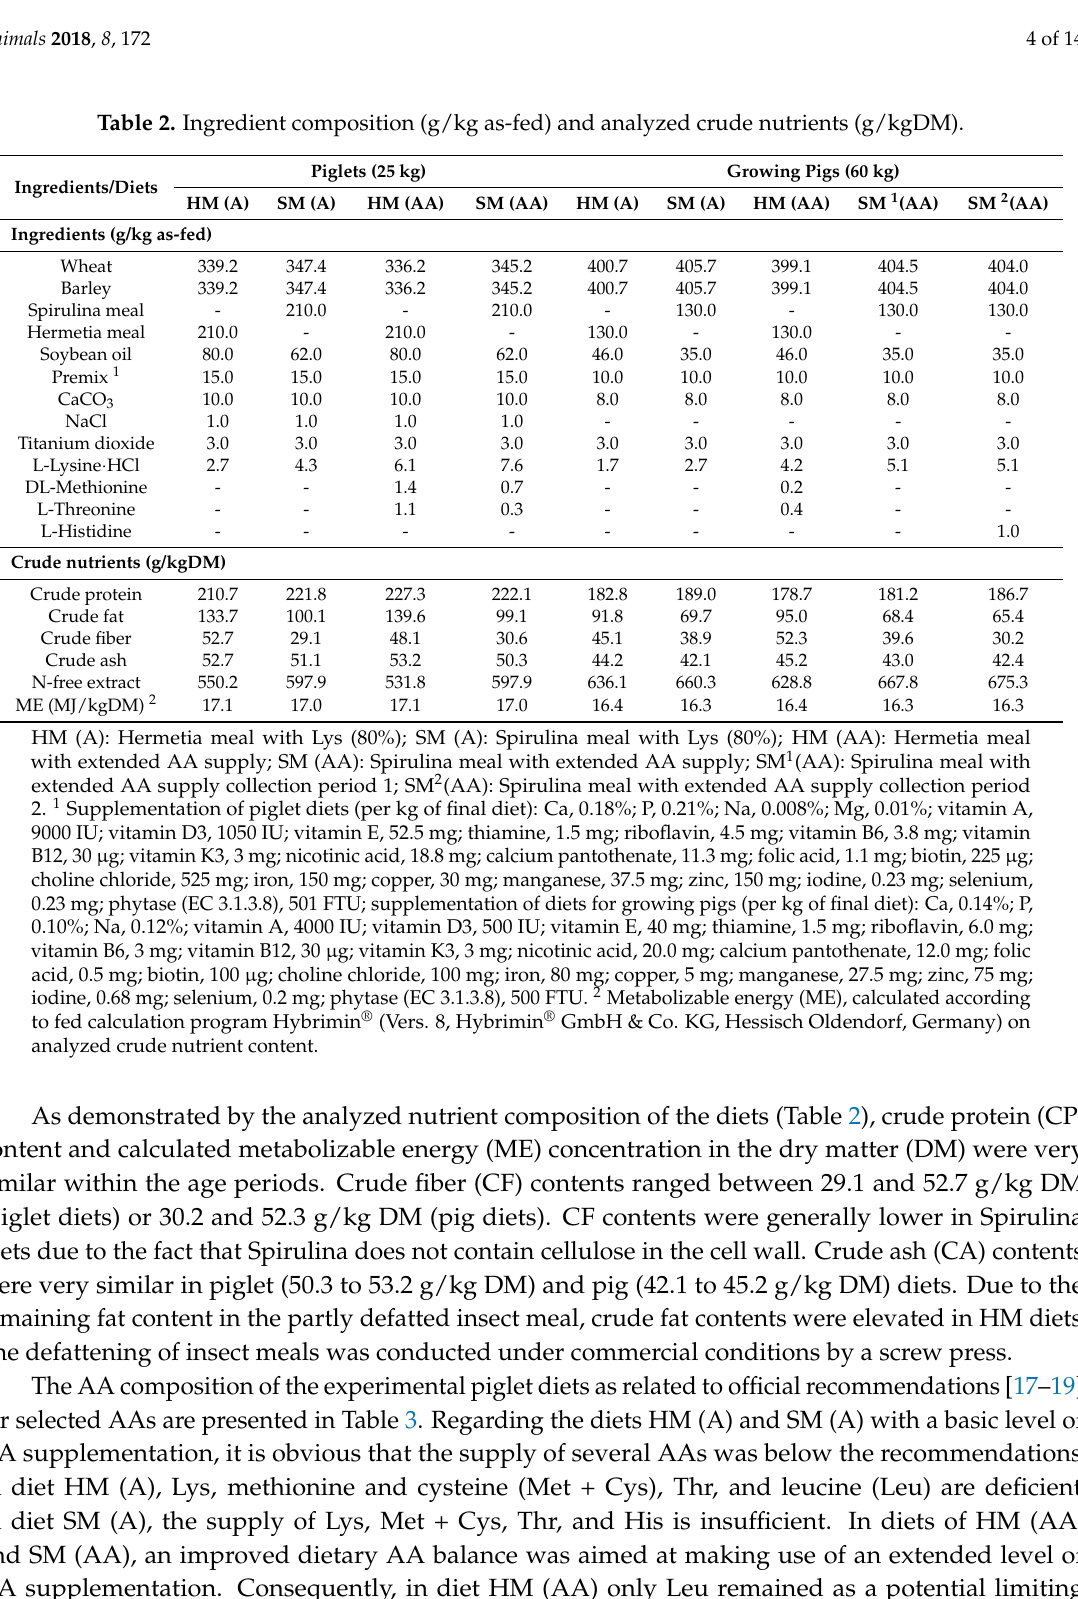
Table 2. Ingredient composition (g/kg as-fed) and analyzed crude nutrients (g/kgDM). Ingredients/Diets Ingredients (g/kg as-fed) Wheat